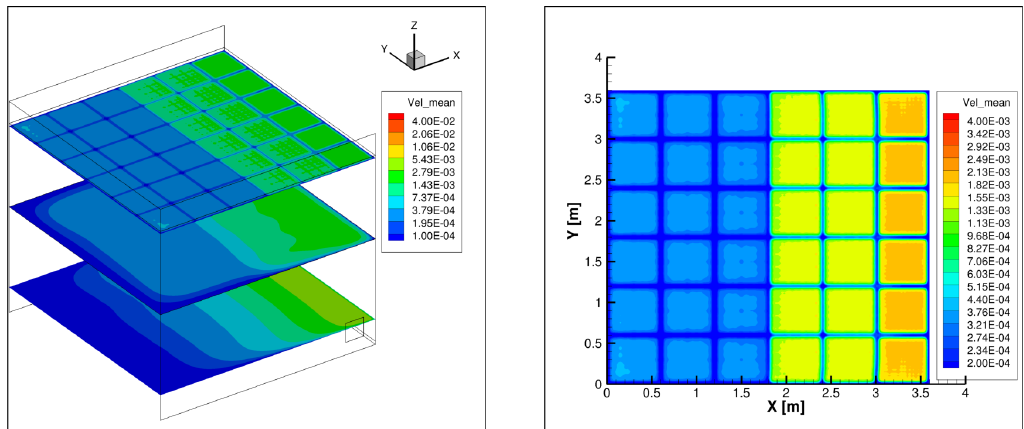
Figure 9. Velocity contour: three horizontal planes (left); the top plane below the ceiling (right) for the continuous distribution in configuration Outlet